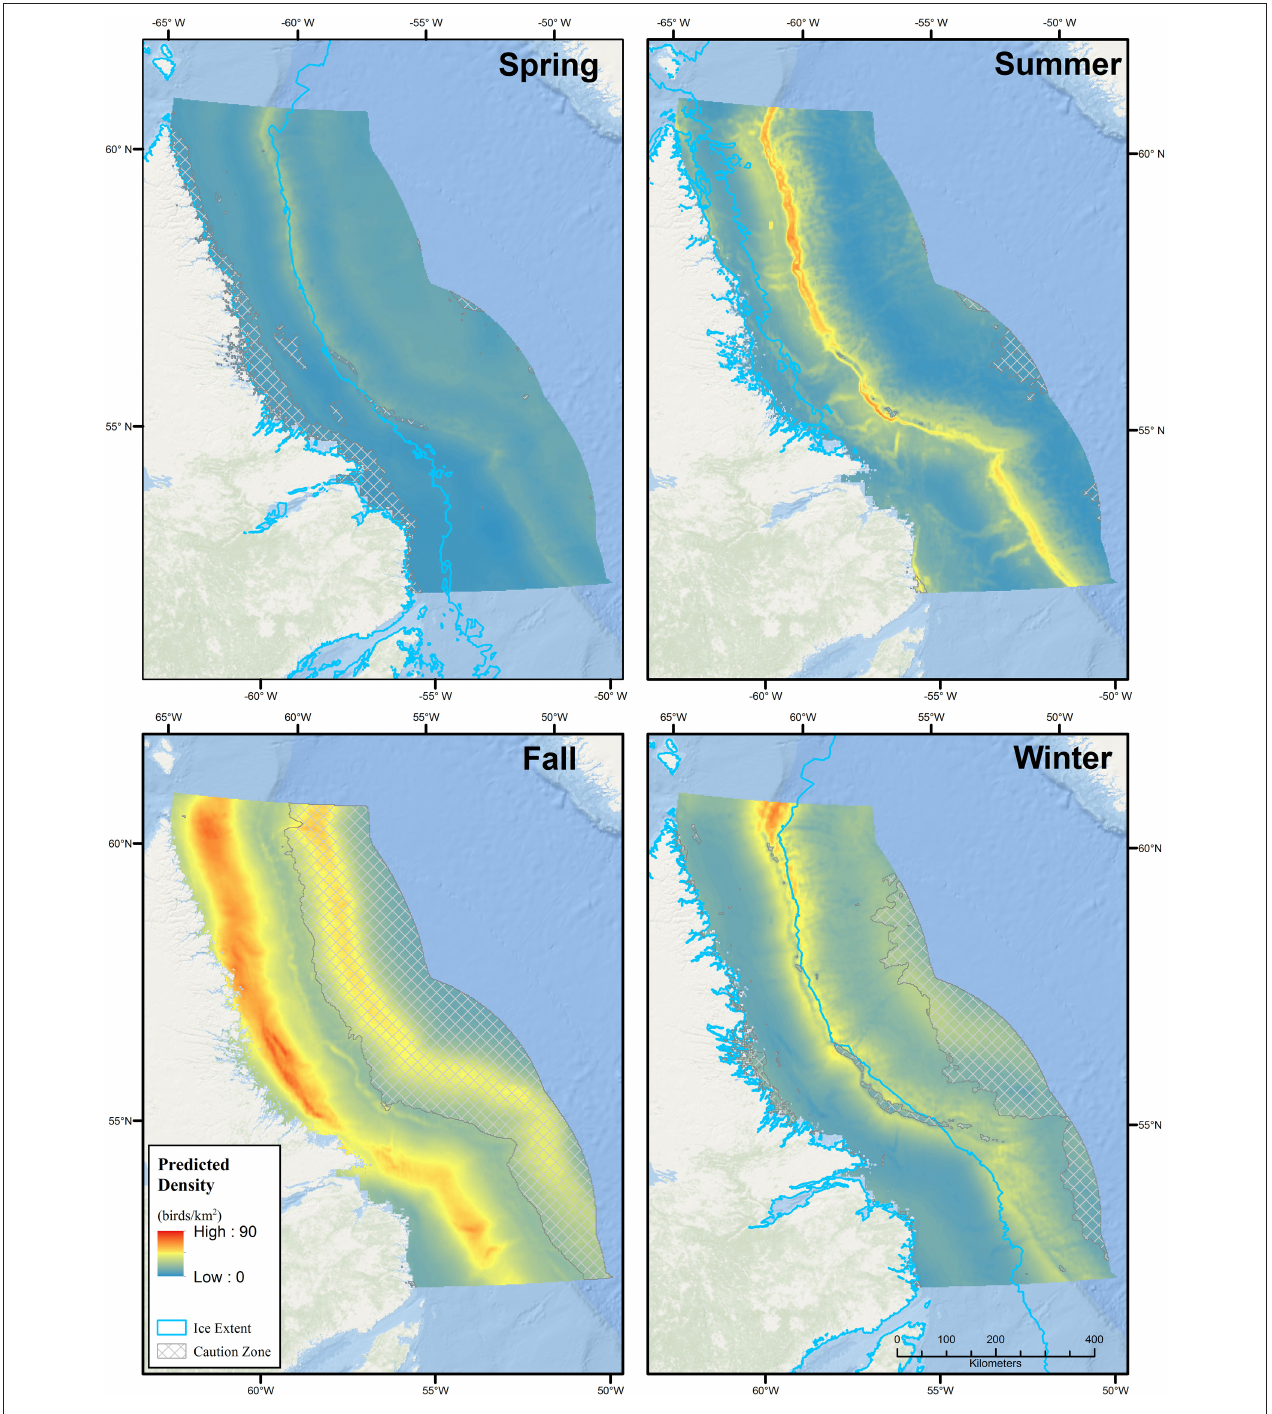
FIGURE 2 | Seasonal predicted densities of all seabirds based on Generalized Additive Models (GAMs). Areas of extrapolation beyond the range of model covariates are indicated with crosshatching. Seasons are defined as Summer (June–August), Fall (September–October), Winter (November–March), and Spring